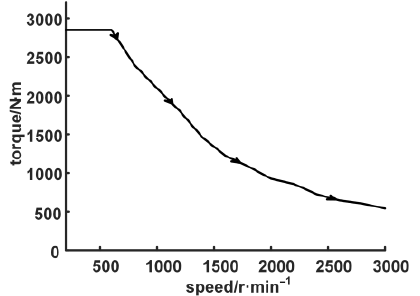
Figure 9. PMSM external characteristic curve.